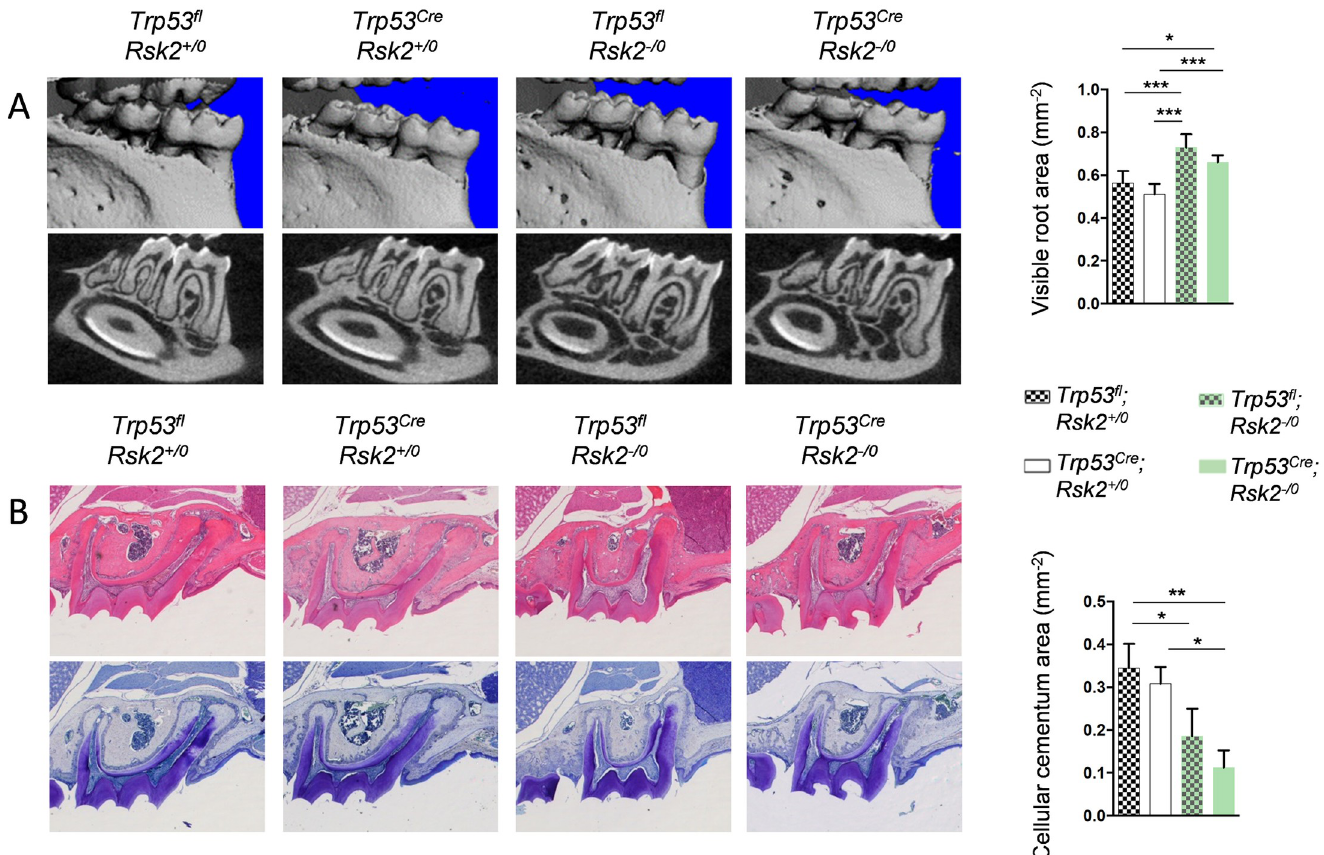
Fig 6. The dental phenotype of Rsk2 -deficient mice is not corrected by Runx2-Cre -mediated p53 inactivation. (A) Representative μ CT images of mandibular molars (top) and corresponding grayscale images (bottom) from 6-month-old male mice with the indicated genotypes. Quantification of the visible root area is shown on the right. (B) Hematoxylin (top) and toluidine blue (bottom) staining of molars form the same mice. Quantification of the cellular cementum area is shown on the right. Data represent mean ± SD (n � 6). Asterisks indicate statistically significant differences ( � p < 0.05, �� p < 0.005, ��� p < 0.0005).